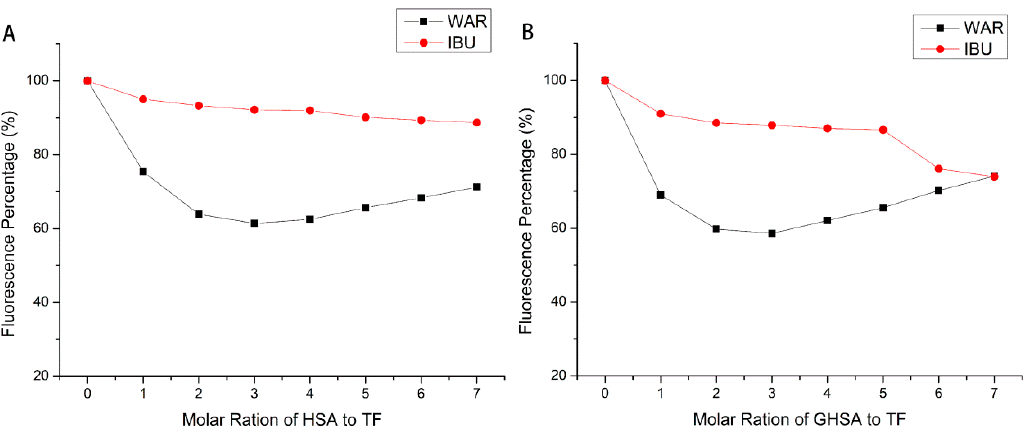
Figure 6. The effect of the site marker on the characteristic fluorescence of HSA ( A ) and GHSA ( B ) at the wavelength of maximum fluorescence intensity.